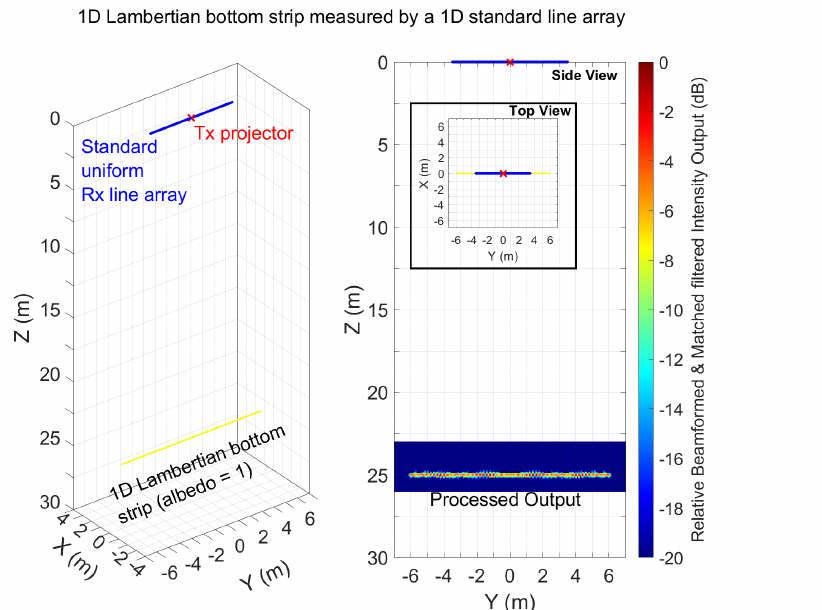
Figure A2. A simulated 1D Lambertian seafloor strip imaged by a dense uniform line receive array. A 0.05 s linear frequency-modulated transmit waveform at 33 ± 3 kHz is projected from a transmit element at the center of the receive array. The received signal at each receive element is matched filtered and then beam-formed for each spatial voxel position. Scattered energy is well-contained within the seafloor region. No random ambient noise is